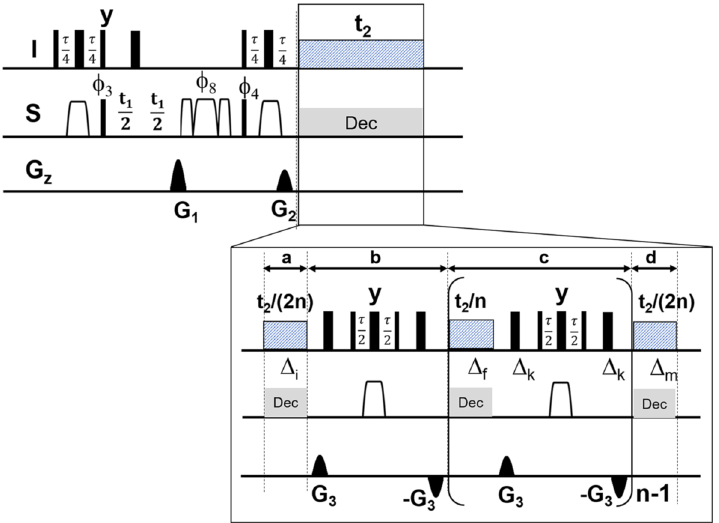
Figure 1. For obtaining 2D restricted random decoupled (RRD) BIRD HSQC spectra, the depicted pulse sequence is used. Proton spin multiplicities are removed by real time homodecoupling during the physical acquisition time using the indicated BIRD r,X elements and chunk data blocks as shown in the insert. Details on experimental parameters are given below. Unless stated otherwise, pulses are applied along the x-axis. Narrow and wide filled rectangles represent non-selective 1 H or 13 C 90° and 180° pulses, respectively. The chirp pulses files are taken from the Bruker library: Crp60,0.5,20.1 is a smoothed chirp pulse for inversion with a pulse length of 500 µs and is shown as open trapezoid. Crp60comp.4 43,44 is a composite chirp refocusing pulse with a pulse length of 2 ms and is shown as a triple of open trapezoids. The chirp pulses were defined with 1000 points and 4000 points, respectively, a sweep width of 60 kHz and 20% smoothing. The power of the chirp pulse was adjusted to a level equivalent to that of a 90° rectangular pulse of 25.5 µs (9.8 kHz), which corresponds to a Q factor of 5 (determined with Shape Tool). The pulsed field gradients indicated as filled sine envelopes are 1 ms and 0.3 ms in length with an amplitude according to a smoothed rectangle (10% smoothing on either side). The gradient files are taken from the Bruker library: SMSQ10.100 (1 ms) and SMSQ10.50 (0.3 ms). They are used for coherence selection (G 1 , G 2 ) and artefact suppression (G 3 ). The amplitudes of the gradient pulses have the following ratio: G 1 = 80%, G 2 = 20.1%, G 3 = 35% (with 100% corresponding to 53.5 G/cm). The pulsed field gradients are applied along the z-axis followed by a gradient recovery delay of 200 us. The loop parameter n applied for the repeated BIRD decoupling was set to 12 leading to an initial chunk delay length of ∆ = 10.6 ms. This is a compromise between keeping the number of RF blocks small and at the same time not allowing too much J evolution to occur. The length of the chunk and decoupling blocks were varied by a limited number of randomly chosen delays between 0 and 10 ms, the exact list of delays employed is given in the Supplementary Material. The RRD HD HSQC spectrum was recorded using 8 scans (minimum of 4 scans) per increment and 2 s relaxation delay. The following delay parameter was used: τ = 1/(J CH ) = 6.89 ms, the initial values for the t 1 increment was 3 µs. Frequency discrimination in the 13 C evolution dimension is achieved by an Echo/anti-Echo protocol. Broadband 13 C decoupling was applied during the acquisition (t 2 ) using a decoupler pulse length of 55 µs at a field strength (γB 1max /2π of 4.5 kHz utilizing a garp4 decoupling super cycle given in the Bruker library 45